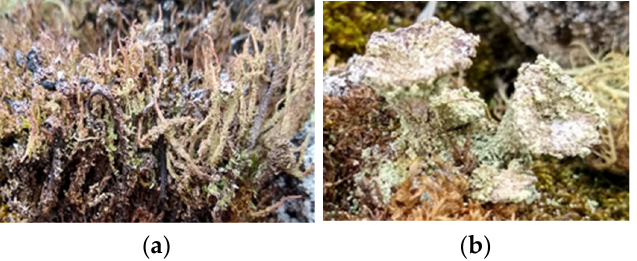
Figure 1. U Lichens thallus in the polar tundra of King George Island, Maritime Antarctic: ( a ) C. gracilis ; ( b ) C. chlorophaea .